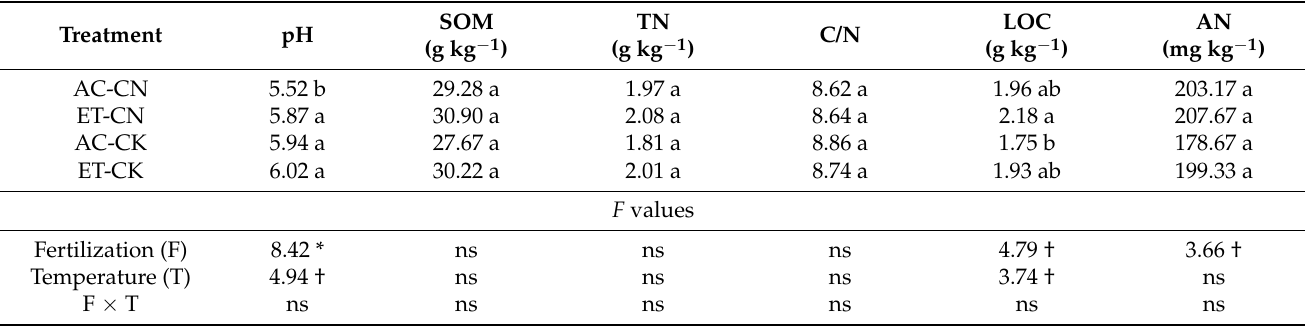
Table 2. Soil physicochemical properties as affected by temperature and fertilization.